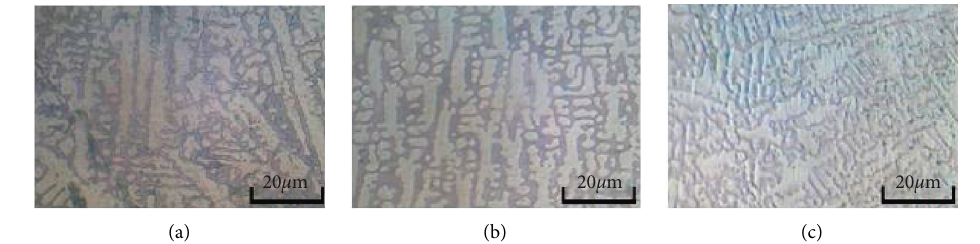
Figure 8: Morphology of the three specimens: (a) microstructure diagram of test specimen 1; (b) microstructure diagram of test specimen 2; (c) microstructure diagram of test specimen 3.